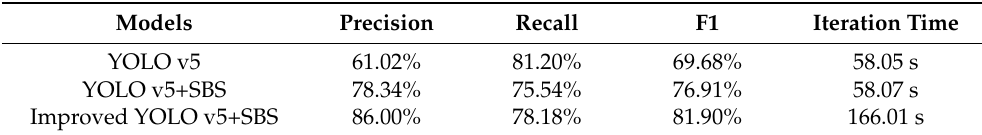
Table 4. Performance comparison of different models.